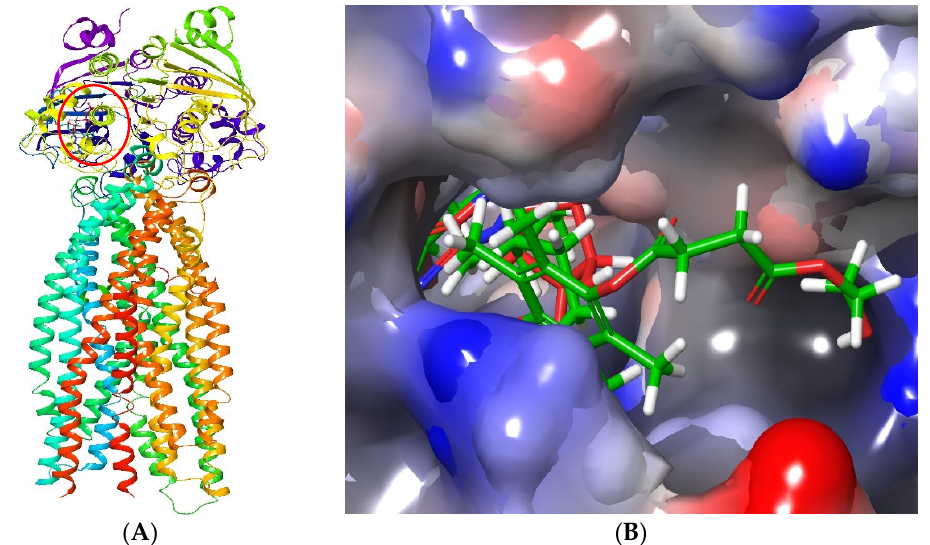
Figure 14. The 3D structures of the superimposed ATP and TPGS in complex with P-gp. ( A ) shows the location of the binding site (NBD) of ATP and TPGS (circled). ( B ) displays the superimposed ligands with ATP (red) confined into the deep binding cavity while TPGS (green), due to its polymeric nature, protrudes to the outside allosteric binding pocket with its hydrophobic α -tocopherol chain.